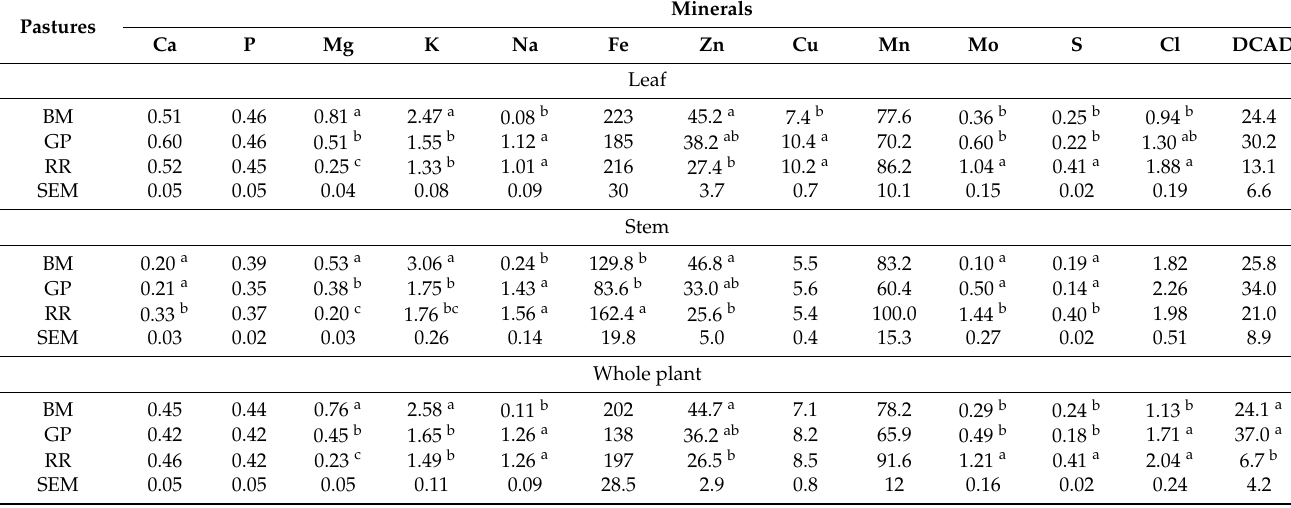
Table 6. Effect of pasture species on mean minerals concentrations measured in leaf and stem fractions of five harvest times at Gatton Research Dairy, Queensland, Australia from November 2020 to May 2021. Calcium (Ca), Phosphorus (P), Magnesium (Mg), Potassium (K), Sodium (Na), Sulphur (S), Chloride (Cl) expressed as percentage dry matter and Iron (Fe), Zinc (Zn), Copper (Cu), Manganese (Mn), Molybdenum (Mo) expressed as PPM and Dietary Cation–Anion Difference (DCAD) in